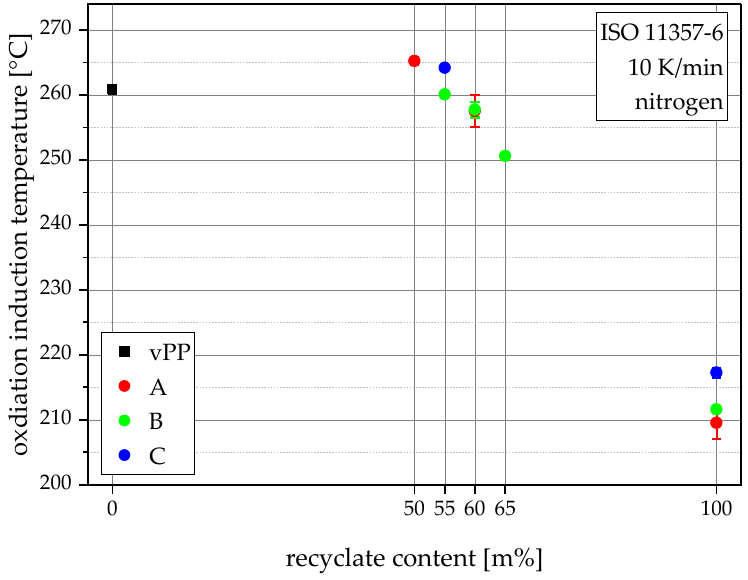
Figure 5. Graphical illustration of oxidation induction temperatures (dynamic OIT) of all materials.